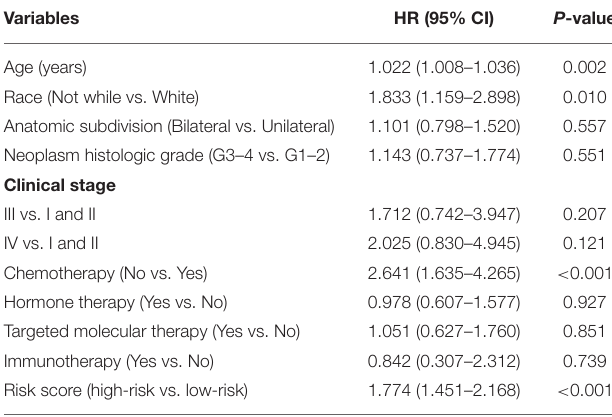
TABLE 5 | Multivariate analyses of risk factors and clinical characteristics on